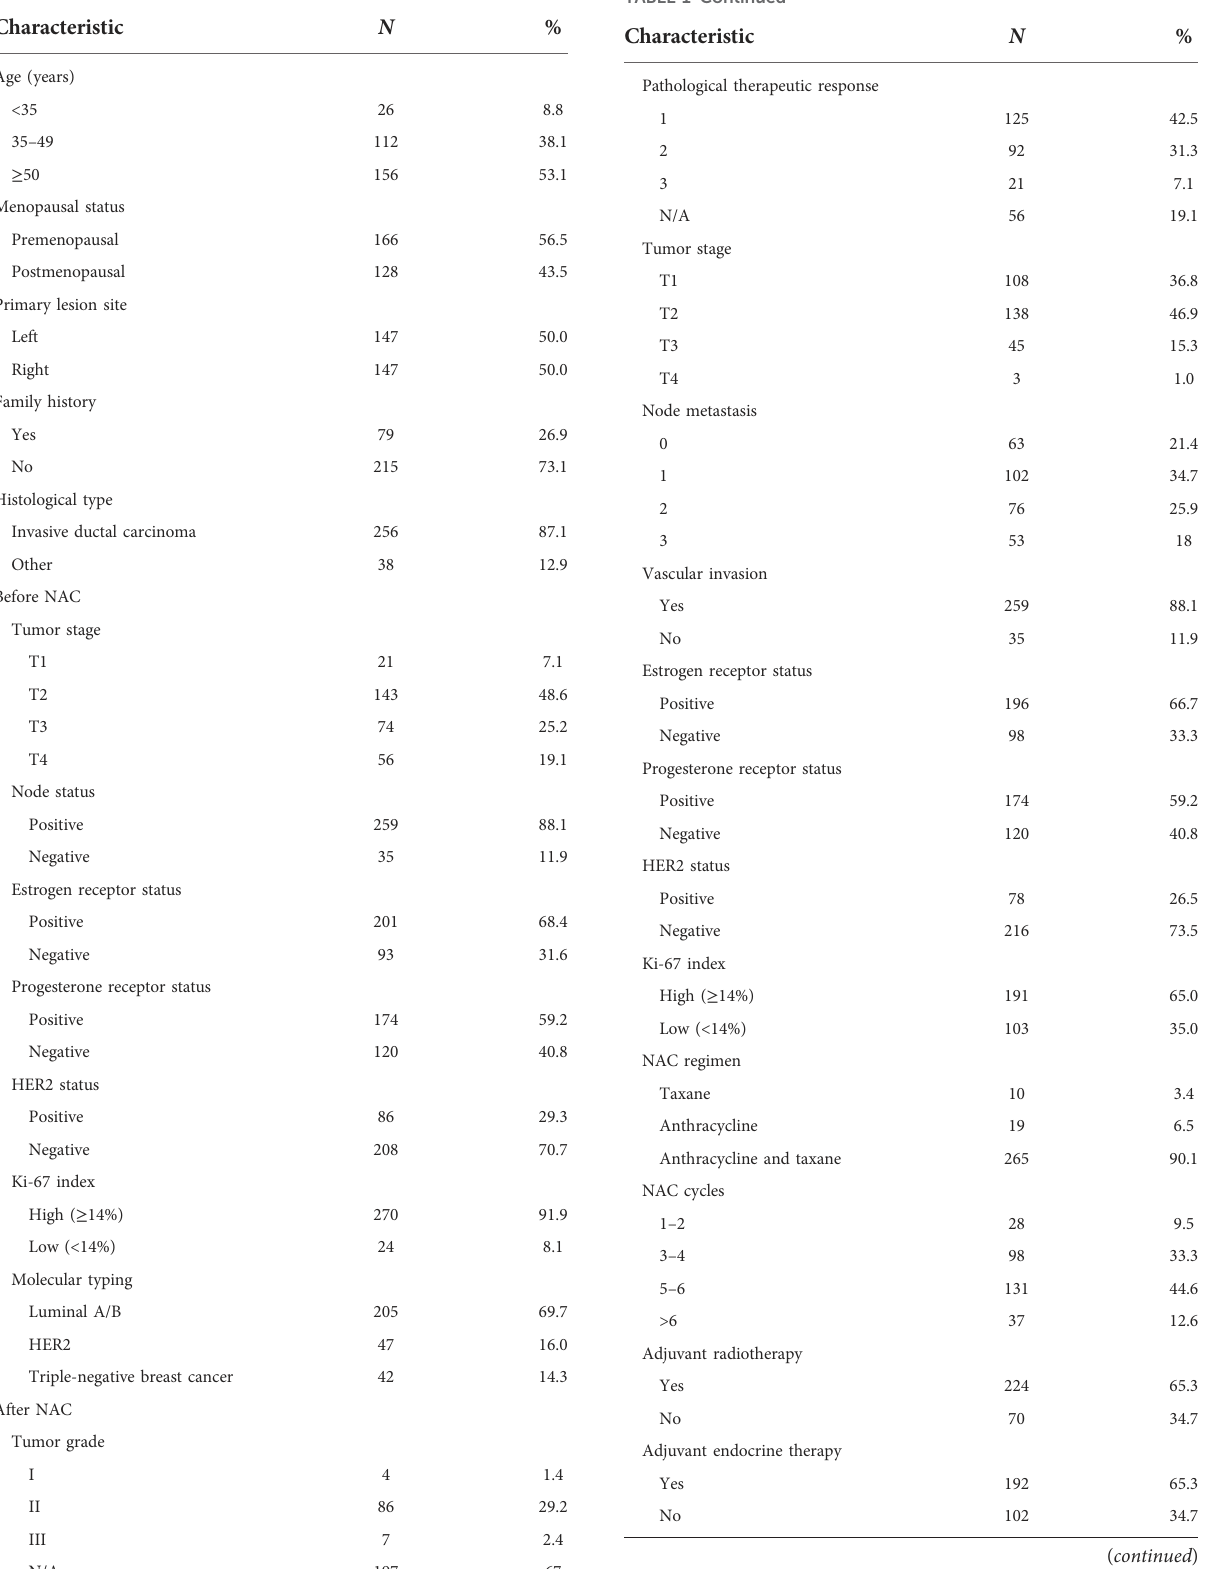
TABLE 1 Patient and tumor